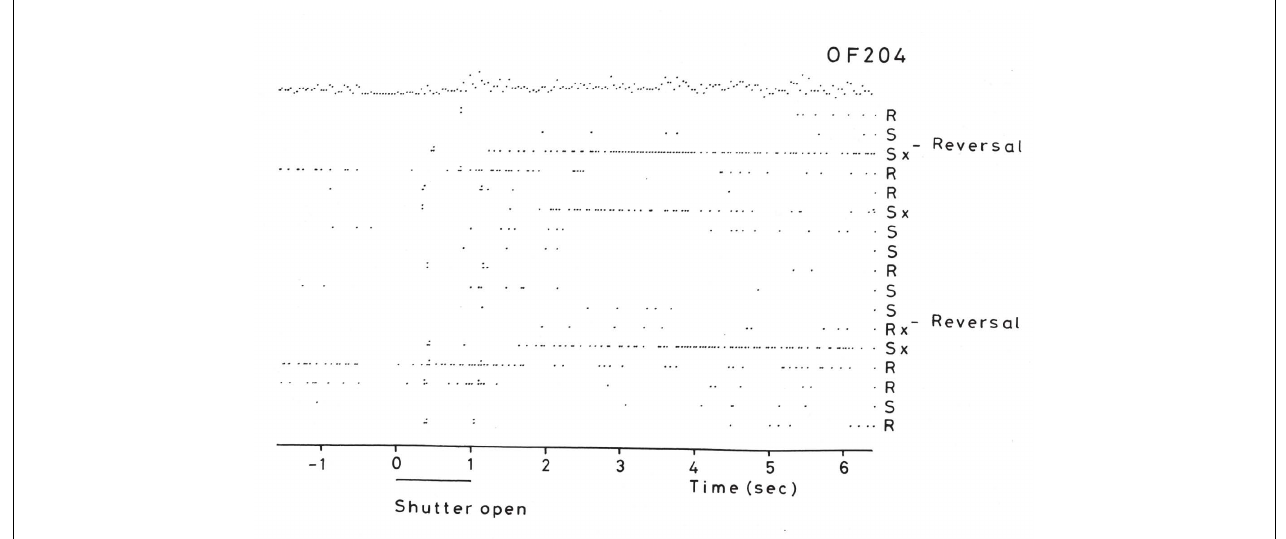
FIGURE 3 |Visual discrimination reversal for sweet taste reward vs. the aversive taste of salt (NaCl). Negative reward prediction error neuron: responses of an orbitofrontal cortex neuron that responded only when the monkey licked to a visual stimulus during reversal, expecting to obtain fruit juice reward, but actually obtained the taste of aversive saline because it was the first trial of reversal. Each single dot represents an action potential; each vertically arranged double dot represents a lick response.The visual stimulus was shown at time 0 for 1s (labeled “shutter open”).The neuron did not